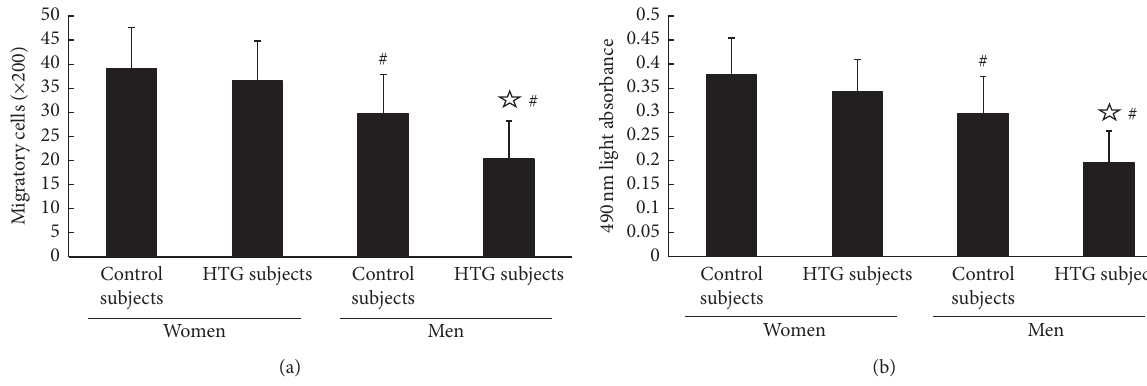
Figure 2: (a) The migratory and (b) the proliferative activities of EPCs were statically elevated in the female groups (both normo- triglyceridemic and hypertriglyceridemic) than those in the male groups. The migratory and the proliferative activities of EPCs were lower in the hypertriglyceridemic men group than those in the normotriglyceridemic men group. However, the migratory and the proliferative activities of EPCs in normotriglyceridemic premenopausal women were similar to those in hypertriglyceridemic premenopausal women. Data were presented as mean and standard deviation. ☆ vs. normotriglyceridemic. #vs premenopausal women.